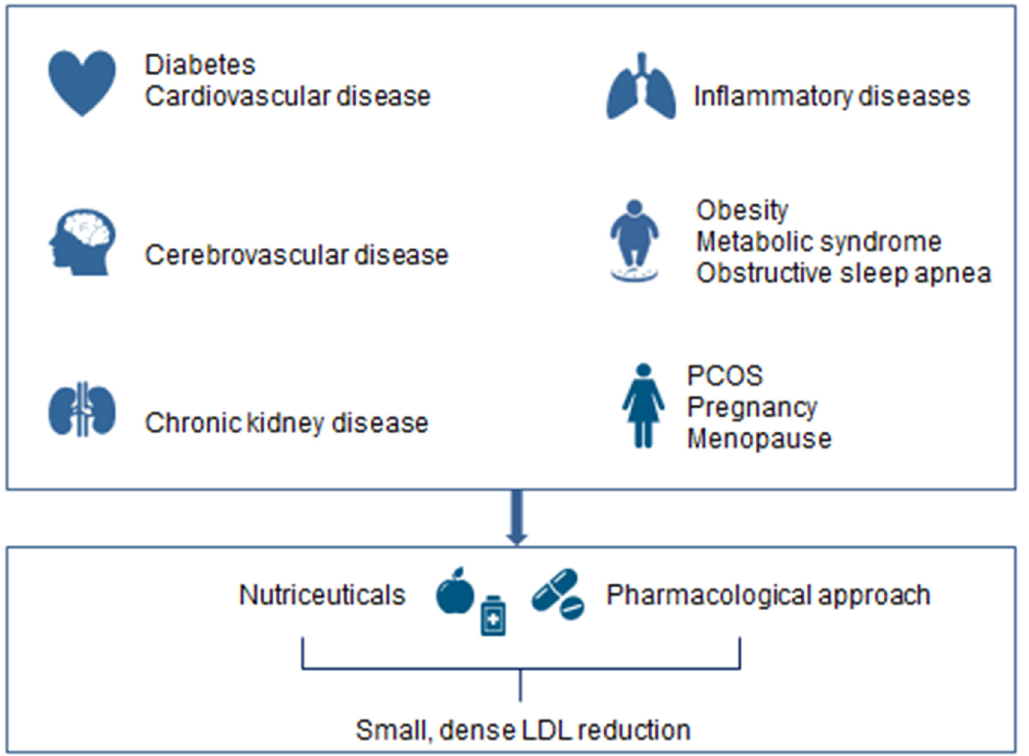
Figure 3. The clinical significance of small dense LDL.